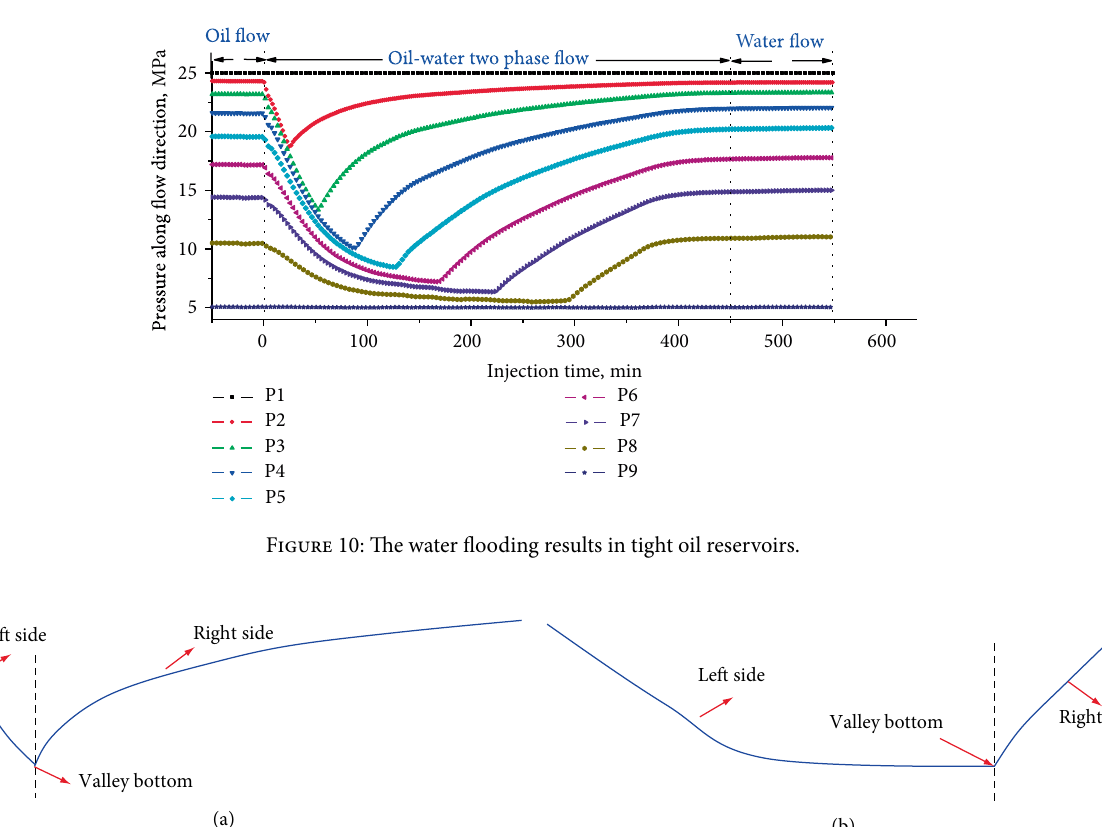
Figure 9: The pressure distribution along the displacement direction in conventional sandstone samples.